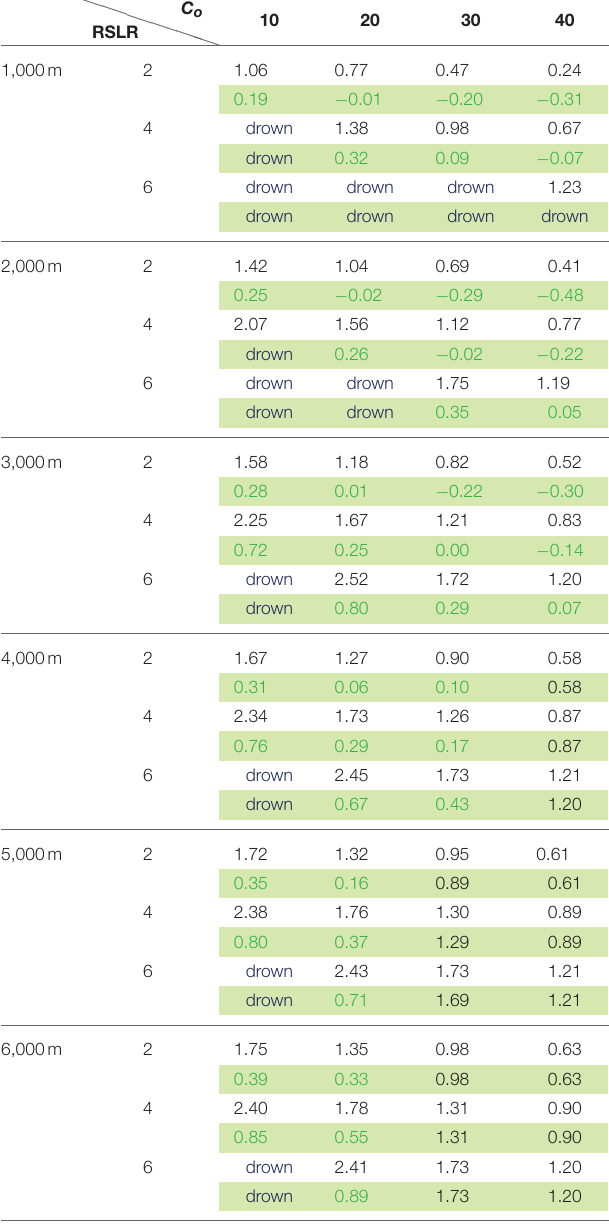
Non-shaded rows are results without seagrass, shaded rows are runs where seagrass was allowed to develop and numbers in green are cases where seagrass is extant at the end of the model